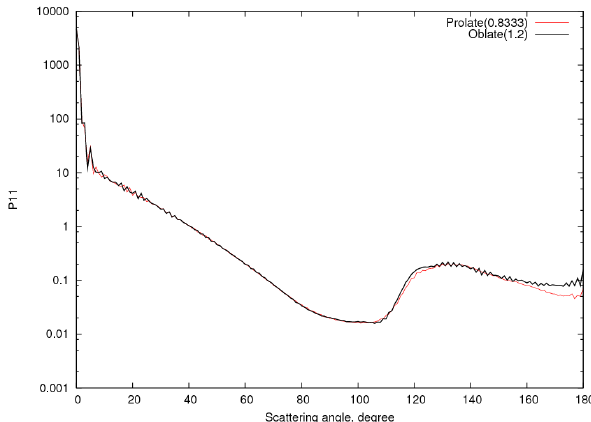
Fig. 2. The normalised scattering phase function plotted against scattering angle, calculated for the prolate spheroid of aspect ratio 0.8333 (red line) and oblate spheroid of aspect ratio 1.2 (full line).